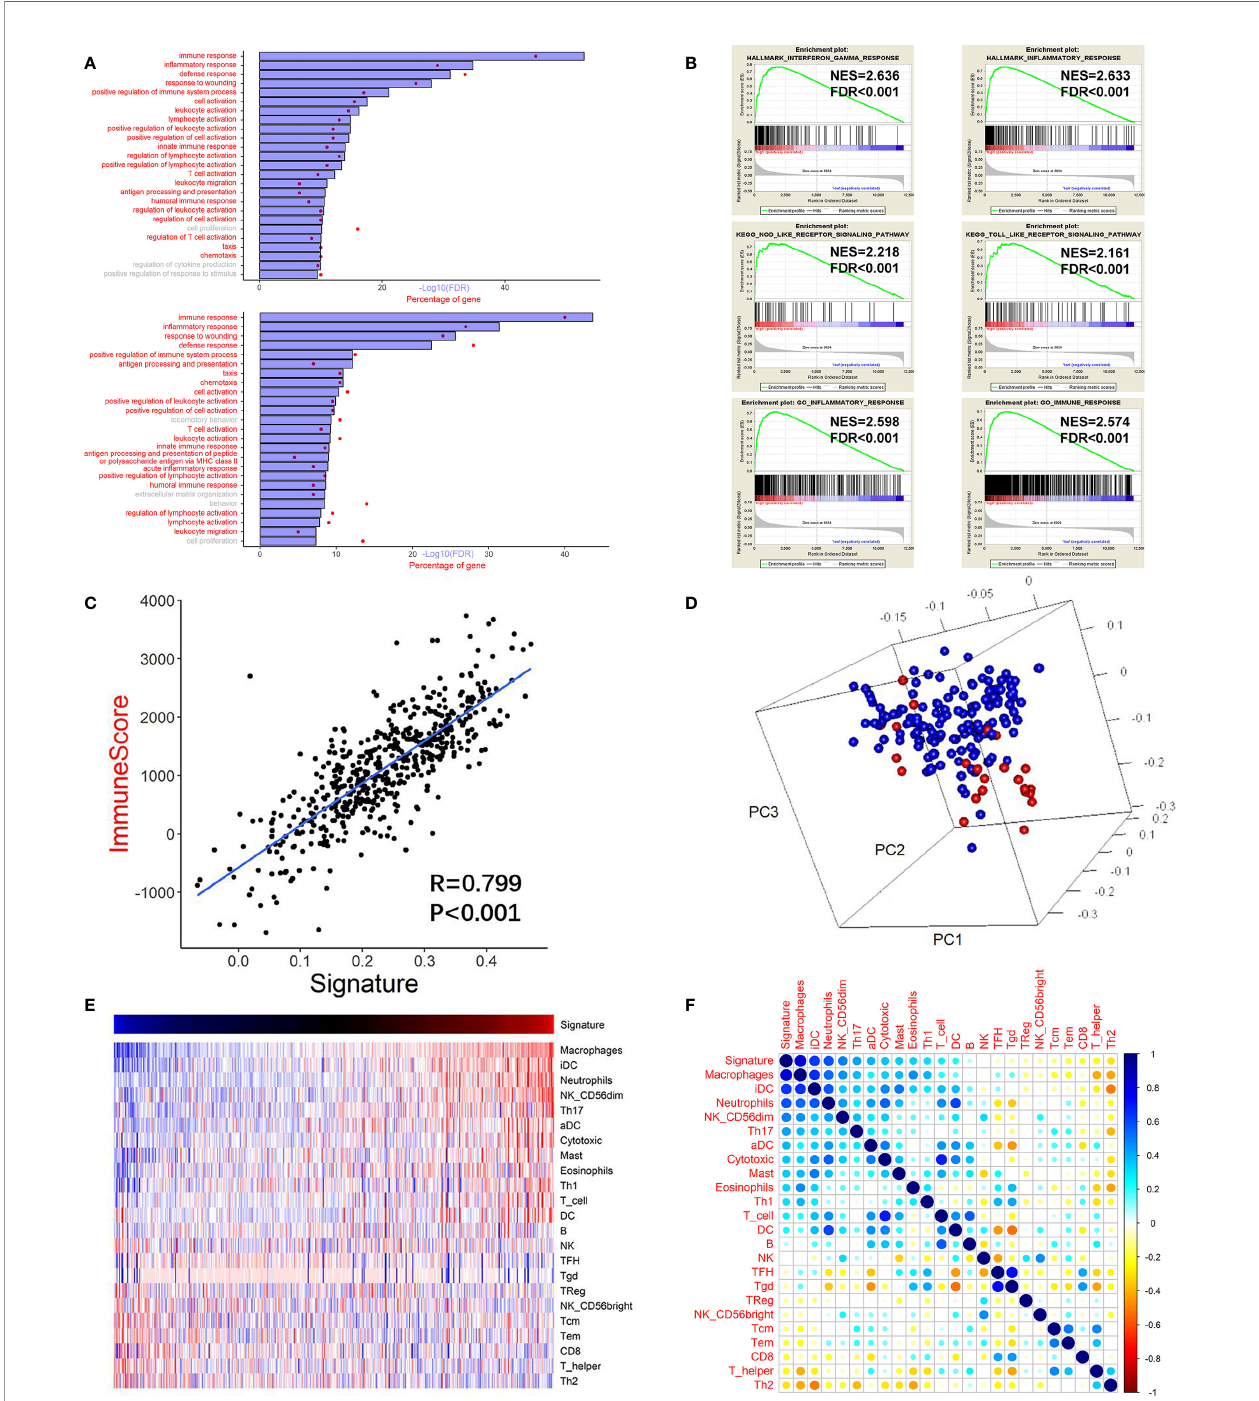
FIGURE 4 | High risk score GBM exhibited immune and in fl ammatory enriched phenotype. (A) Upper chart: Top 25 GO terms enriched by genes that correlated highly (r > 0.4) with the risk score, suggested that they were highly enriched in immunity, in fl ammation, and related processes (red). Lower chart: Top 25 GO terms enriched by the upregulated DEGs (at the FDR of 0.05 and the lowest log fold change of 0.5) analyzed between the high risk score group and the low risk score group. (B) GSEA analysis reveals that the risk score was associated with processes or pathways closely associated with immunity, in fl ammation, and related processes. (C) Pearson correlation analysis between the risk score (signature) and the immune score of the training cohort. (D) PCA showing that the genes used to construct the risk score were highly associated with the genes used to construct the immune score gene set. Red: genes of the risk score gene set; Blue: genes of the immune score gene set. (E) Heatmap showing the relationship between the risk score (signature) and the ssGSEA score of each immune cell. Red: high score; Blue: low score. (F) Pearson correlation analysis between the risk score and the ssGSEA score of each immune cell. The vertical bar indicates the r